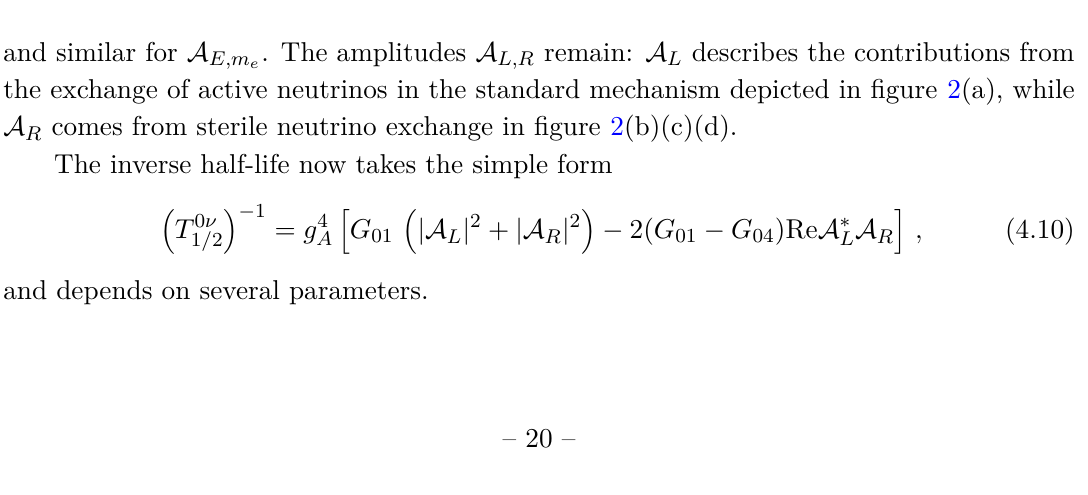
and ν denote the insertion of Majorana mass terms L R and ν L R